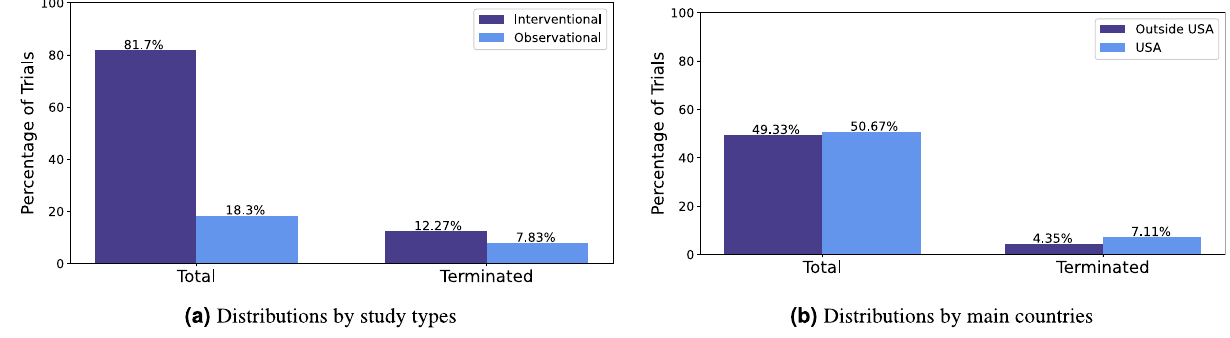
Figure 3. Distributions of clinical trials by study types ( a ); and by main countries ( b